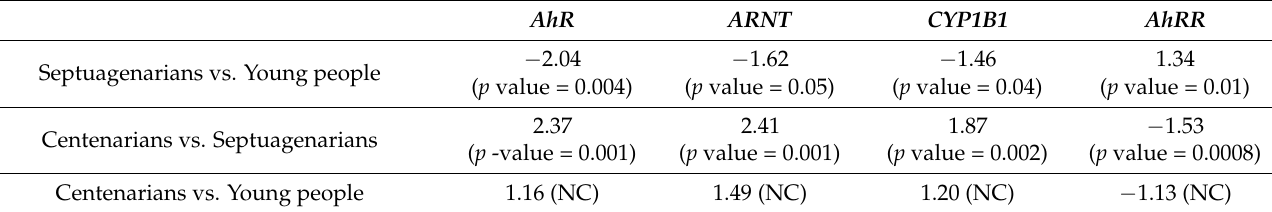
Table 4. Differential expression genes involved in the AhR pathway. AhR ARNT CYP1B1 AhRR Septuagenarians vs. Young